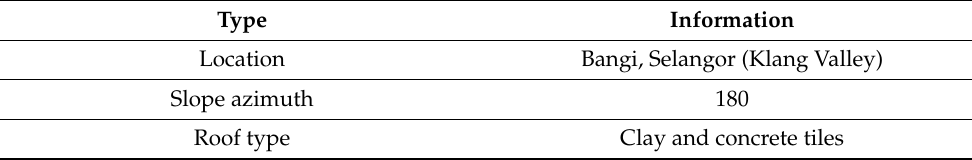
Table 2. Site Information.